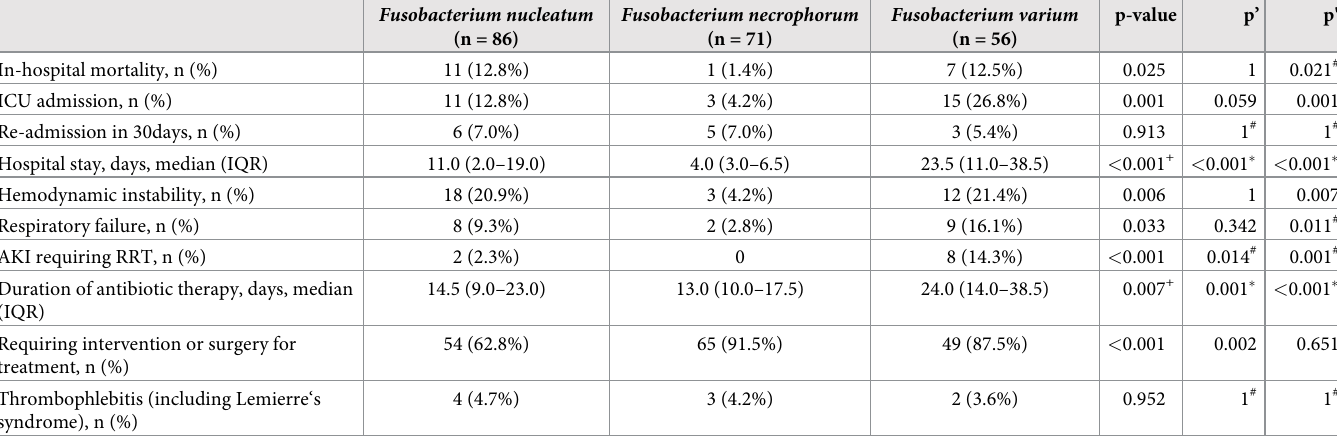
Table 2. Outcome analysis of Fusobacterial